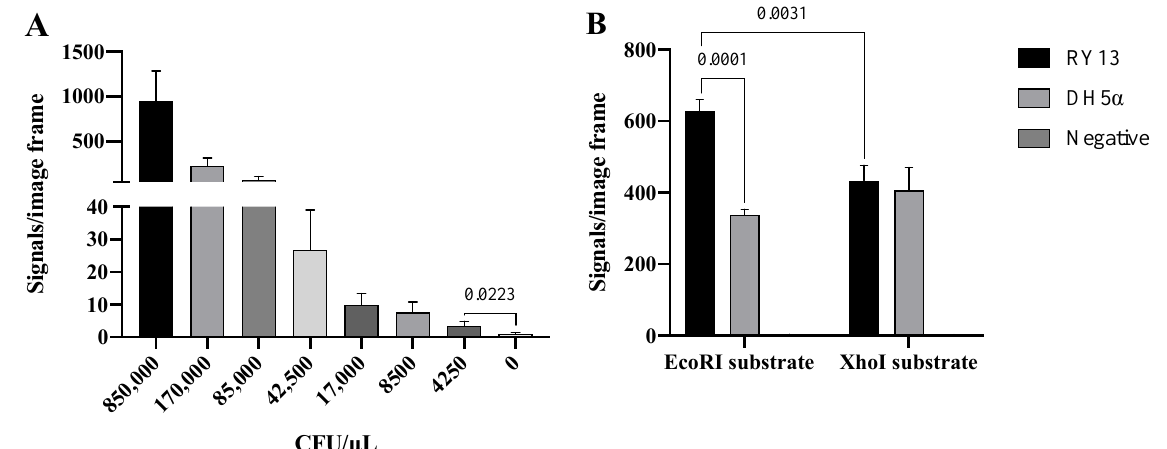
Figure 3. Detection of RE activity in cell extracts. ( A ) Titration of 850,000–4250 CFU/ µ L RY13 E. coli with the EcoRI substrate system. ( B ) Extract from 170,000 CFU/ µ L RY13 and DH5 α on EcoRI and XhoI substrates. The results are plotted as the mean of signals/image frame with standard deviation, n = 3. p -values indicating significant difference as calculated with an unpaired t -test are marked in the graphs.